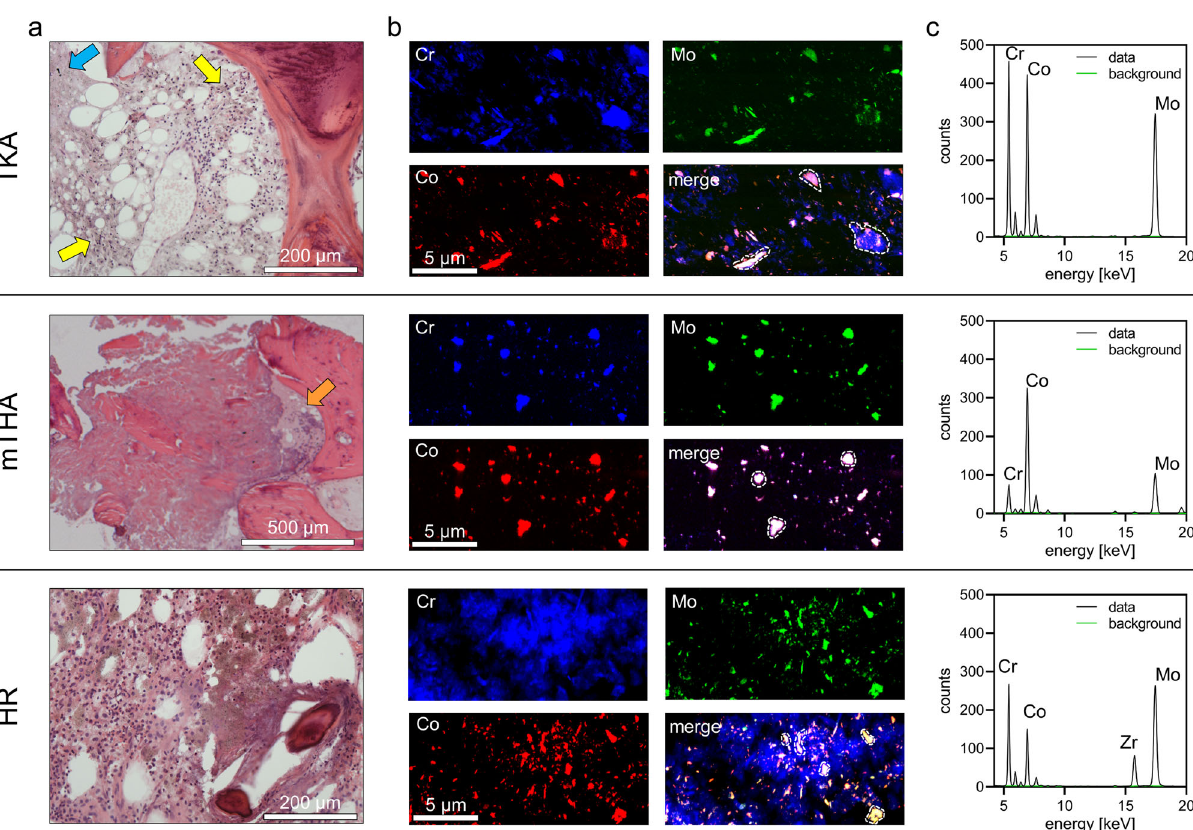
Fig. 3 Exposure to CoCrMo particles in periprosthetic bone marrow samples from three patients undergoing revision surgery of a total knee arthroplasty implant (TKA), a modular hip arthroplasty implant with modular femoral component (mTHA) and a hip resurfacing arthro- plasty implant (HR). a Histopathological evaluations of hematoxylin and eosin stained sections (consecutive sections of the sections ana- lyzed by XRF) revealed presence of micron sized particles (blue arrow) in an area of necrotic macrophages and submicron-particles and particle aggregates in areas with clusters of particle-laden macrophages